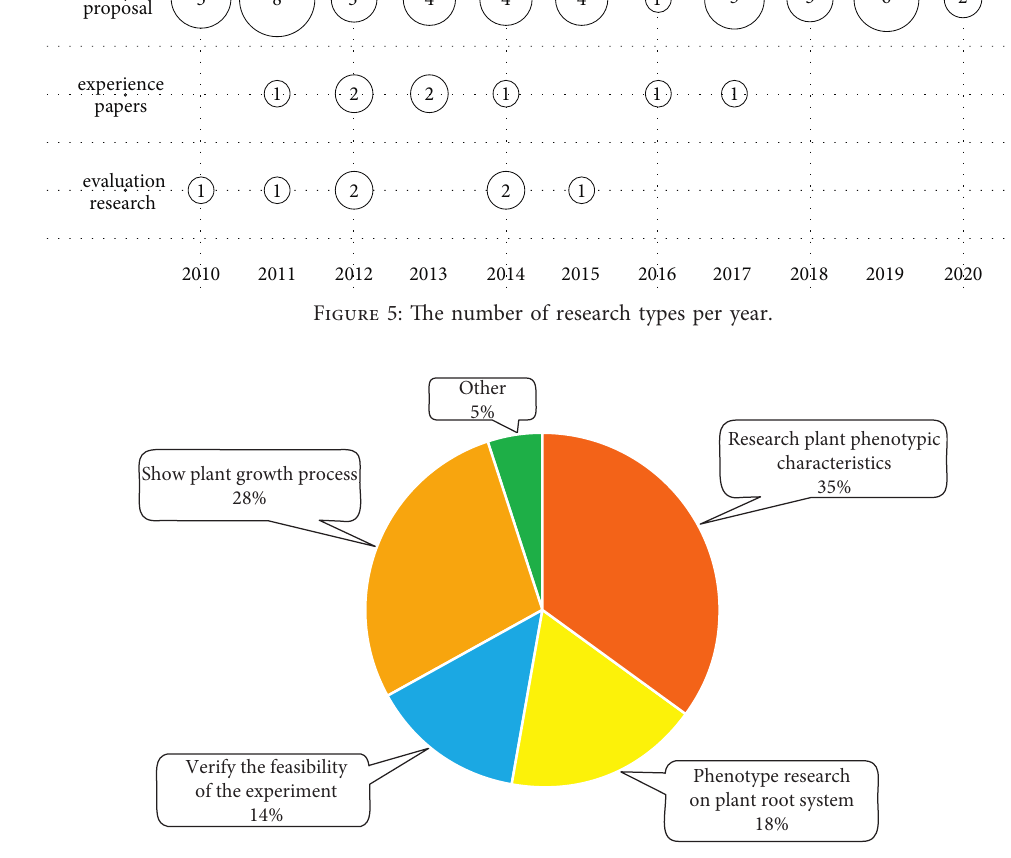
Figure 6: Research goal